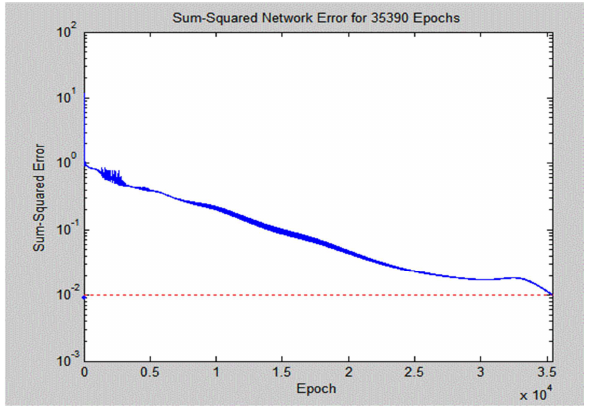
Figure 18. The sum squared network